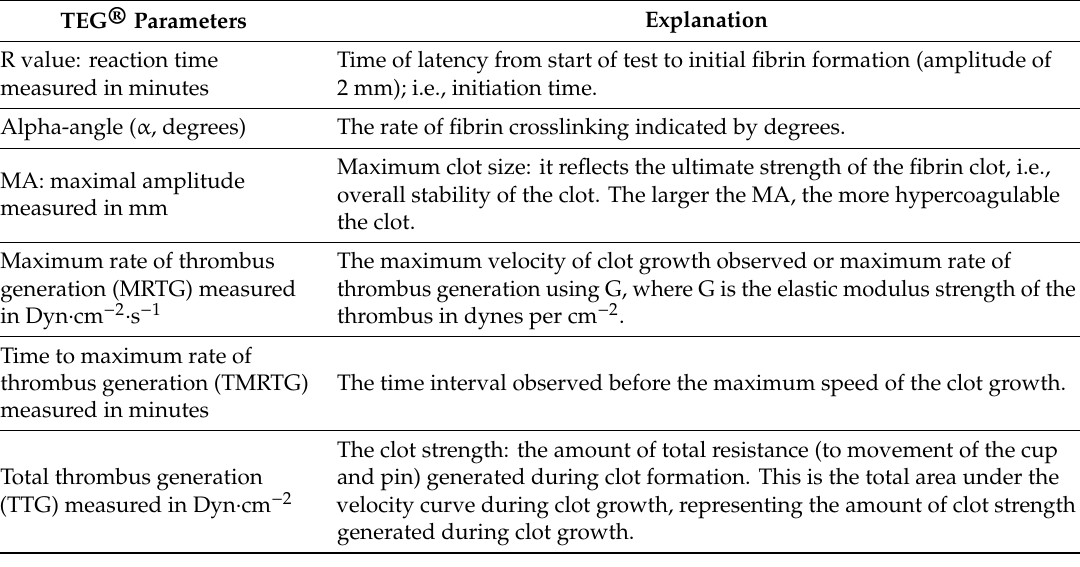
Table 2. Definitions of the various thromboelastography (TEG ® ) parameters, adapted from [23]. TEG ® Parameters